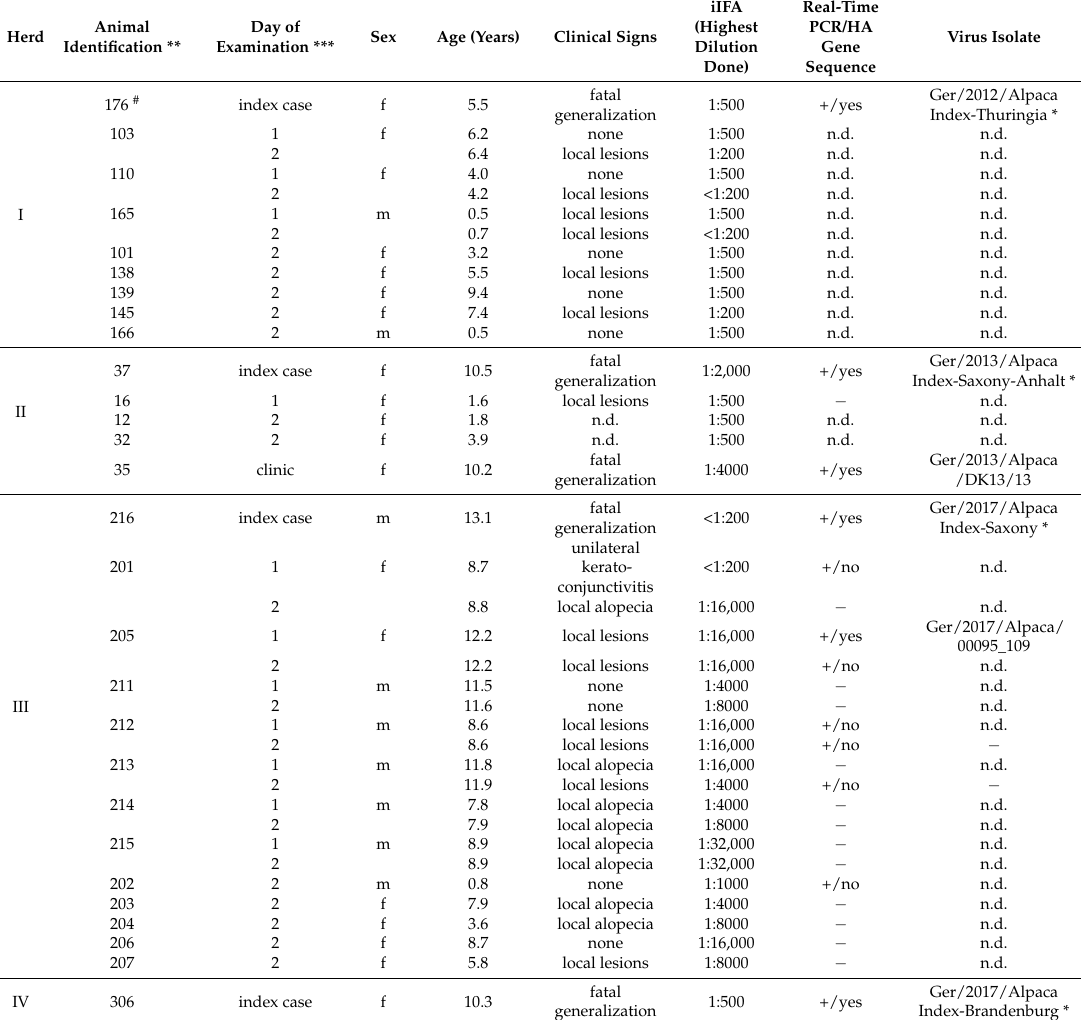
Table 2. Clinical signs and results of cowpox virus investigations of infected alpacas from four herds in Eastern